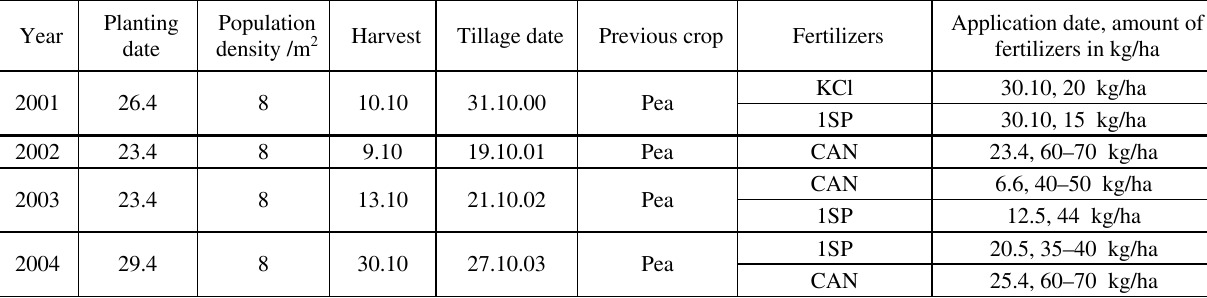
Table 1 . Agricultural inputs to model